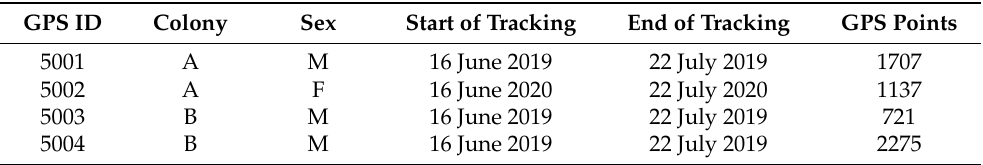
Table 1. Description of the tracked red-footed falcons. Refer to Figure 1 for the positions of Colonies A and B within the study area. GPS ID Colony Sex